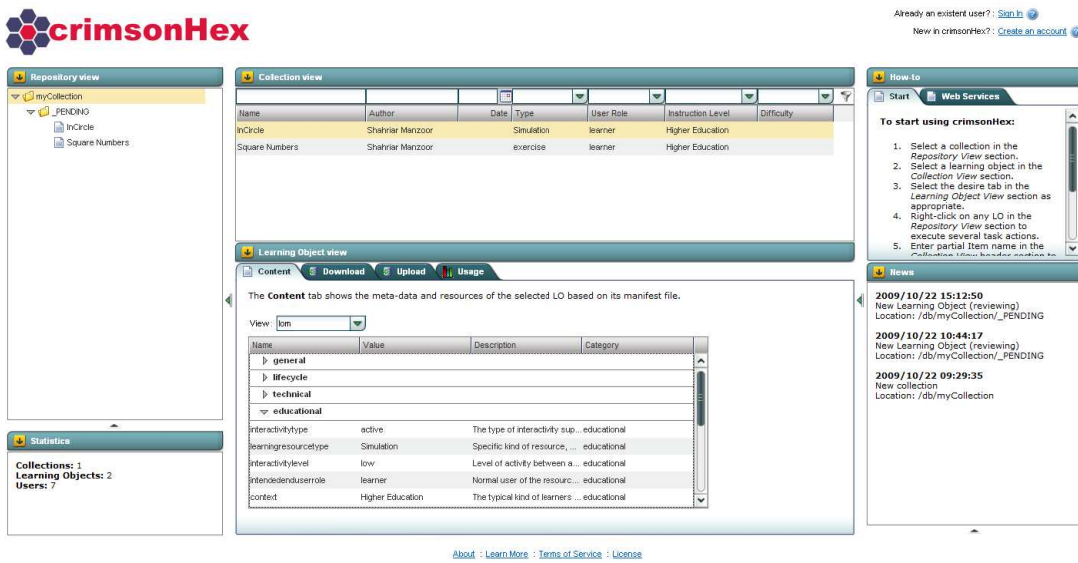
Figure 2. The crimsonHex programming exercise